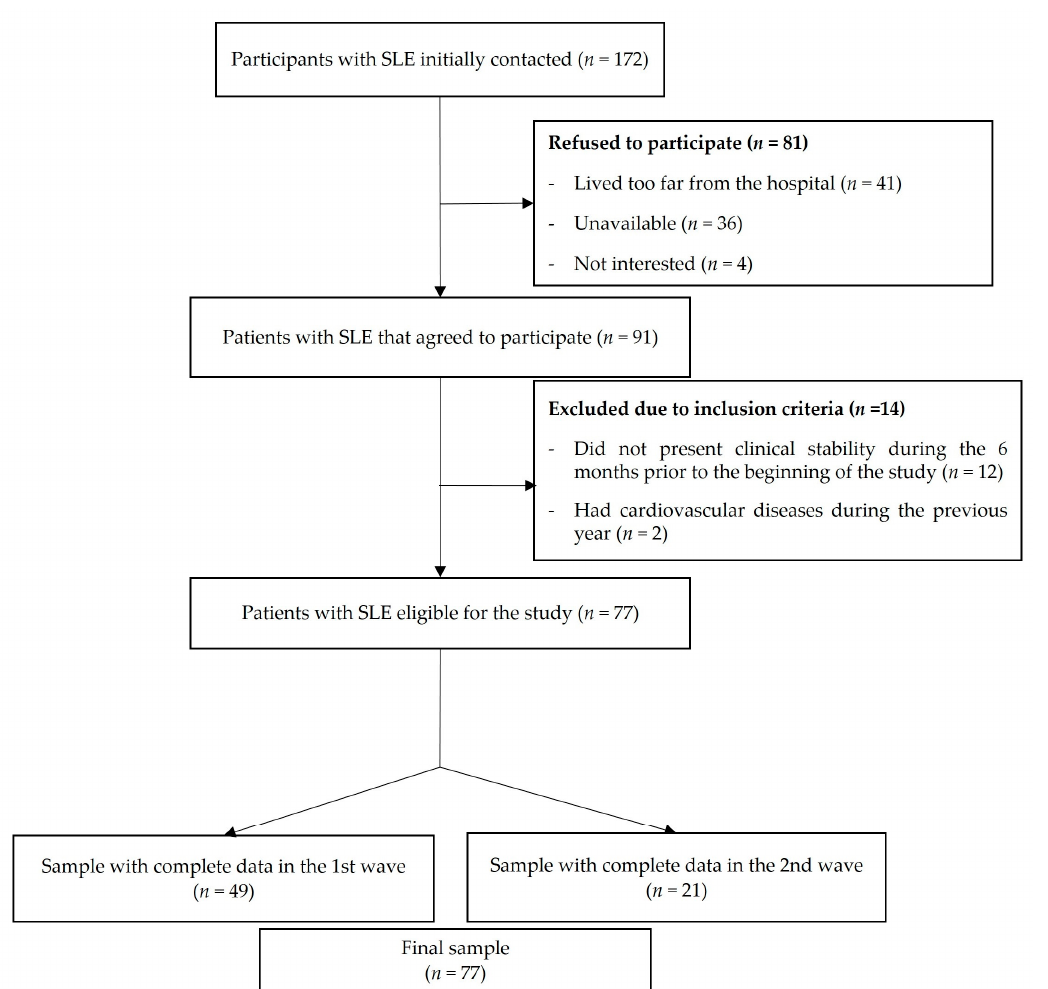
Figure 1. Flow diagram of the inclusion of women with systemic lupus erythematosus (SLE) for the present study.